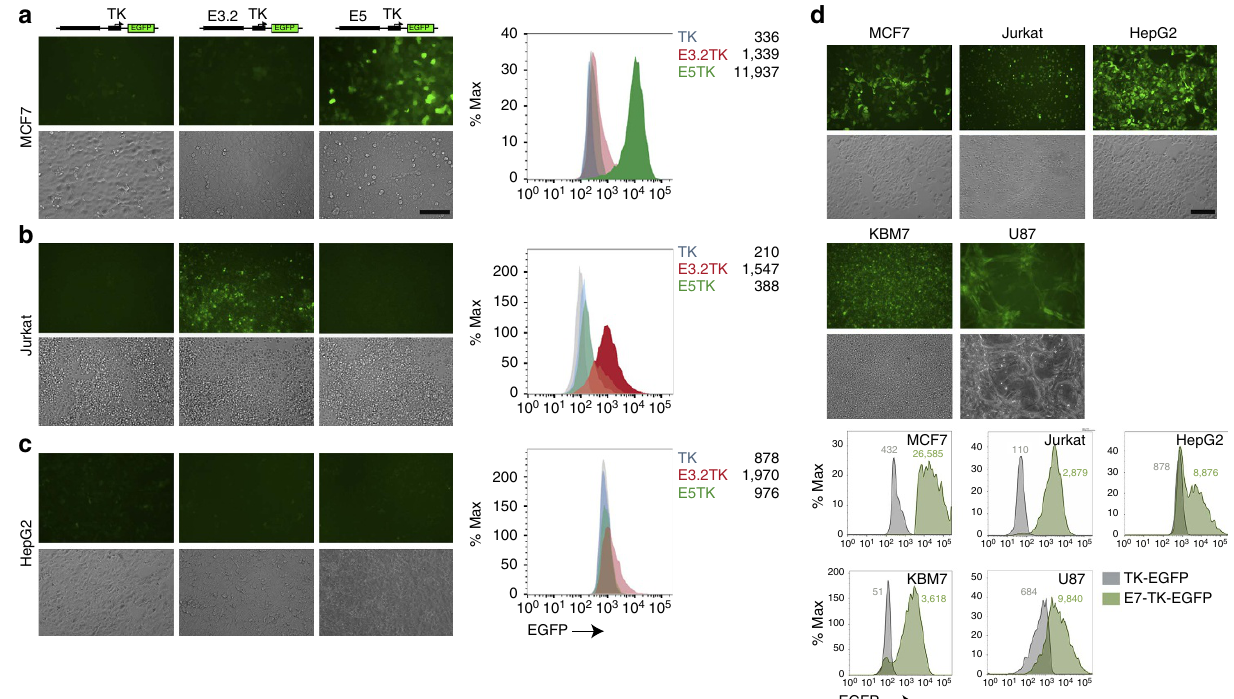
Figure 2 | Identification and characterization of CD47 SEs constituent enhancers. ( a ) In MCF7 cells, specific EGFP reporter expression was activated by the E5 (right panel) CD47 constituent enhancer region but not by E3.2 (middle panel) or others. ( b ) In Jurkat cells, specific EGFP reporter expression was activated by the E3.2 constituent enhancer (middle panel) but not by E5 (right panel) or others. ( c ) Neither E5 (right panel) nor E3.2 (middle panel) constituent enhancers activate reporter expression in HepG2 cells. Control cells transduced with the lentiviral cassette containing the thymidine kinase (TK) minimal promoter only (left panels, a – c ). ( d ) E7 activates EGFP reporter expression in all the cancer cell lines tested, including the HepG2 negative control. Grey images ( a – d ) are corresponding bright field micrographs. Histograms show the mean of EGFP reporter signal measured by flow cytometry. Grey histograms ( a – d ) are the fluorescence minus one (FMO) controls. Scale bars: 100 m